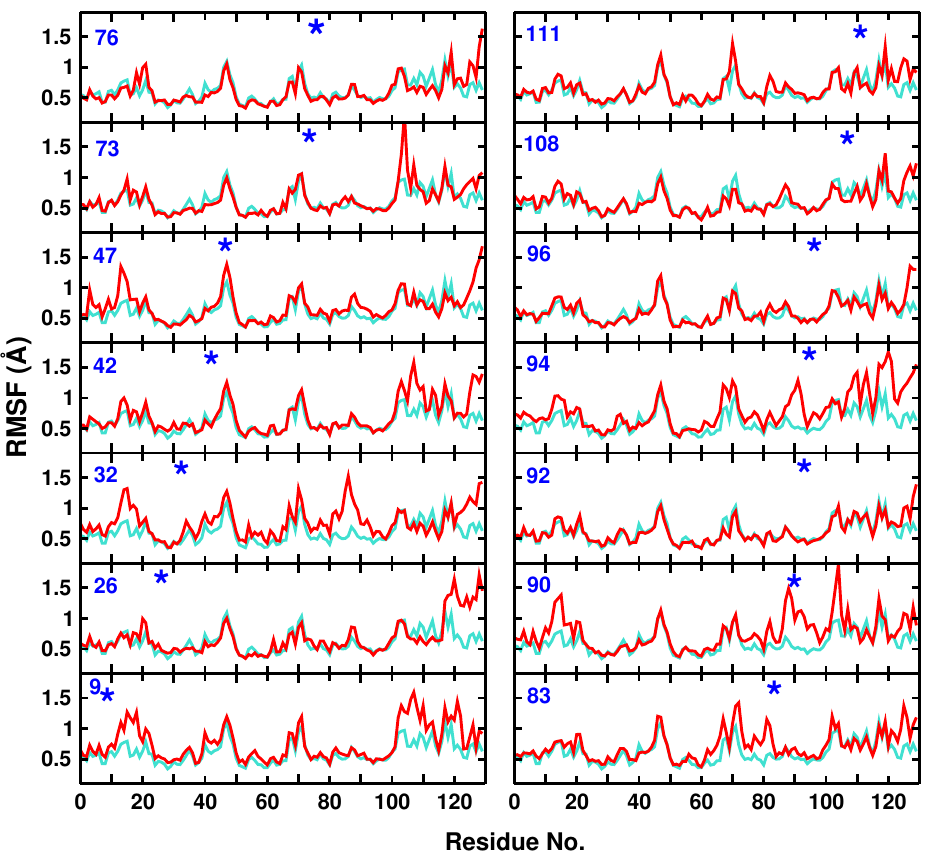
Figure 2. Root mean squared fluctuations for the C α atoms of the WT (turquoise) protein and including different AlaN 3 (red) modification sites. The position of the modified residue is indicated by an